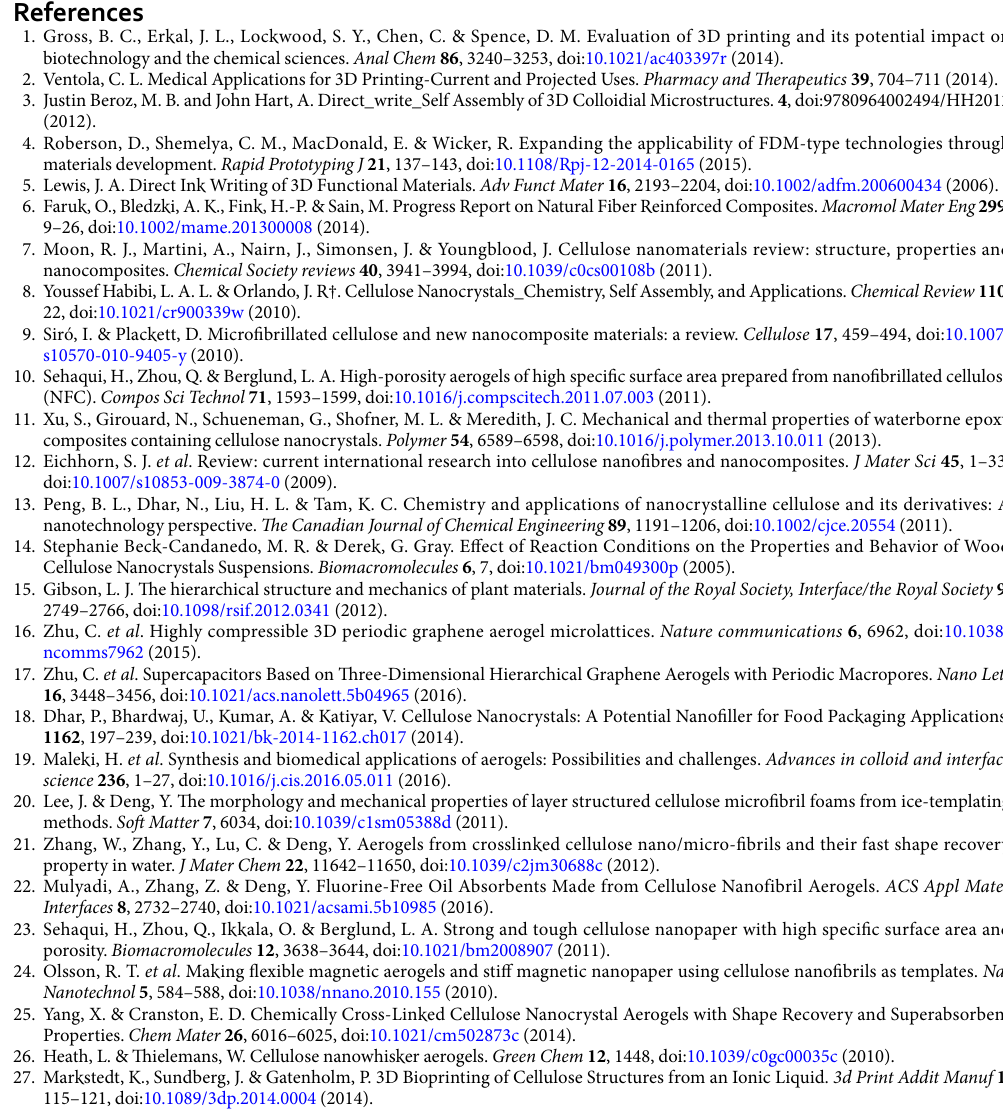
mined through imageJ